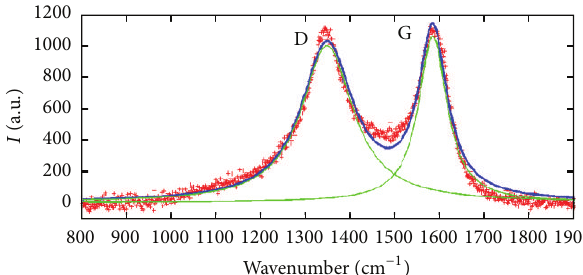
Figure 3: Example of a Raman spectrum obtained with quartz tube carbon and fitted with lorentzian (D) and BWF lineshape (G).